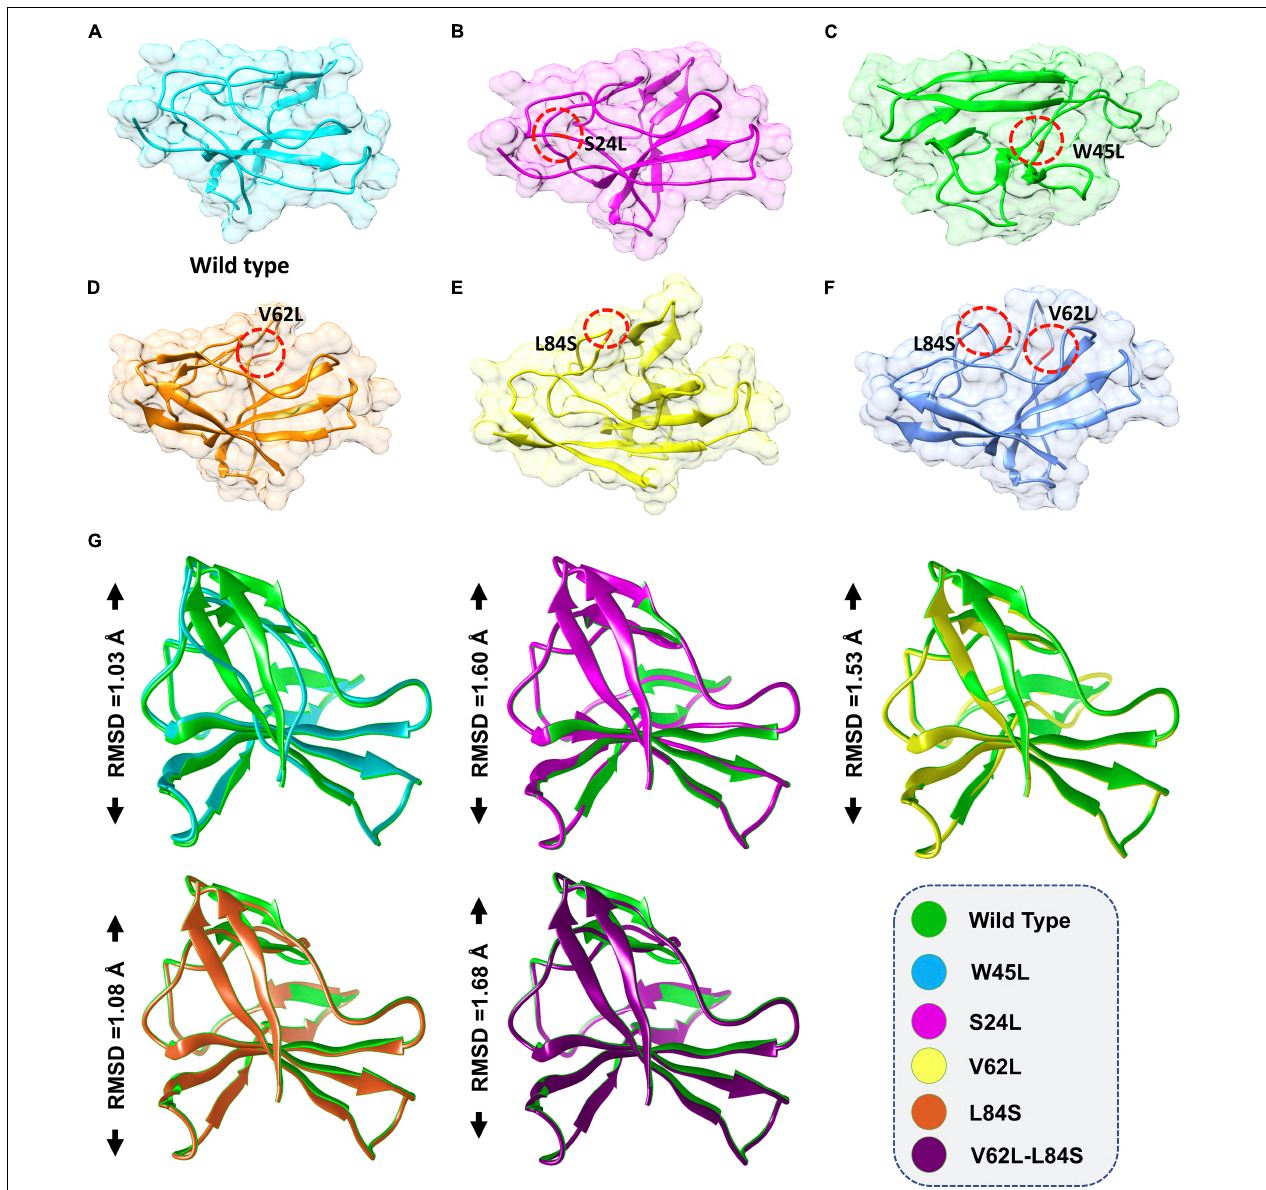
FIGURE 1 | ORF8 mutants modeling and the superimposition of ORF8 WT with ORF8 mutants. (A) ORF8 WT, (B) S24L, (C) W45L, (D) V62L, (E) L84S, (F) V62L, and L84S double mutant (G) . Superimposed structure of ORF8 WT (green) with S24L (light magenta), W45L (cyan), V62L (yellow), L84S (orange), and V62L, L84S (dark magenta). The RMSD values of each superimposition were